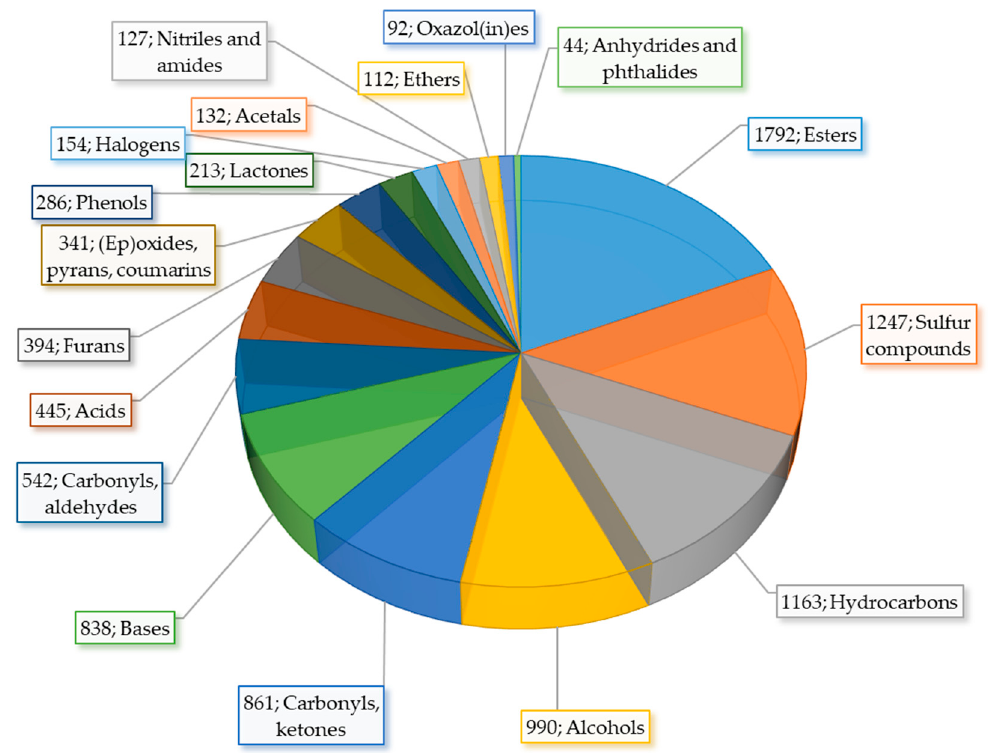
Figure 1. Volatile compounds in food according to volatile compounds in food database based on [28].